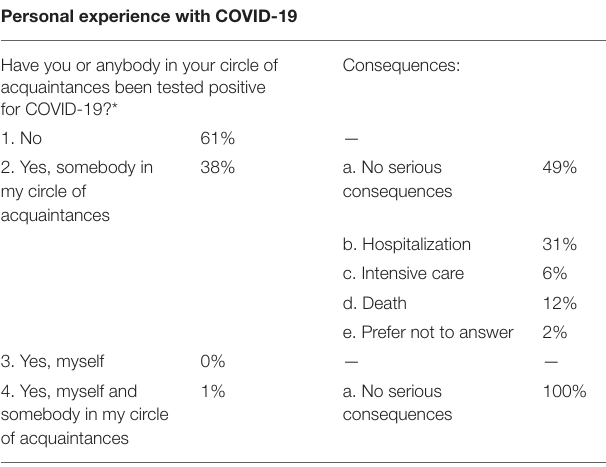
TABLE 3 | Participants’ personal experience with COVID-19.